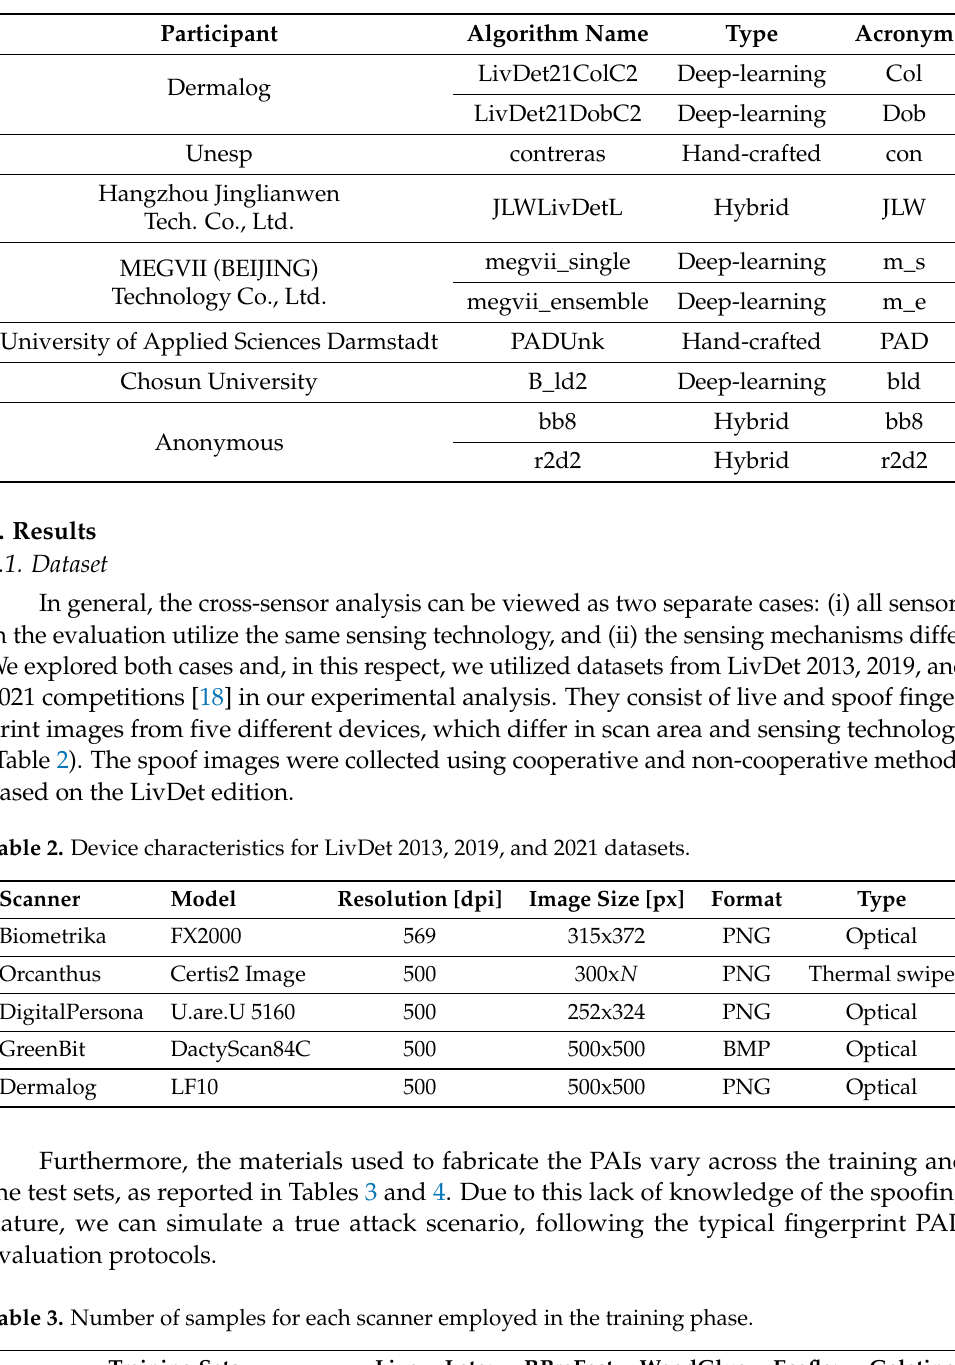
Table 1. Characteristics of the pre-trained PAD LivDet 2021 competitors used for the analysis.